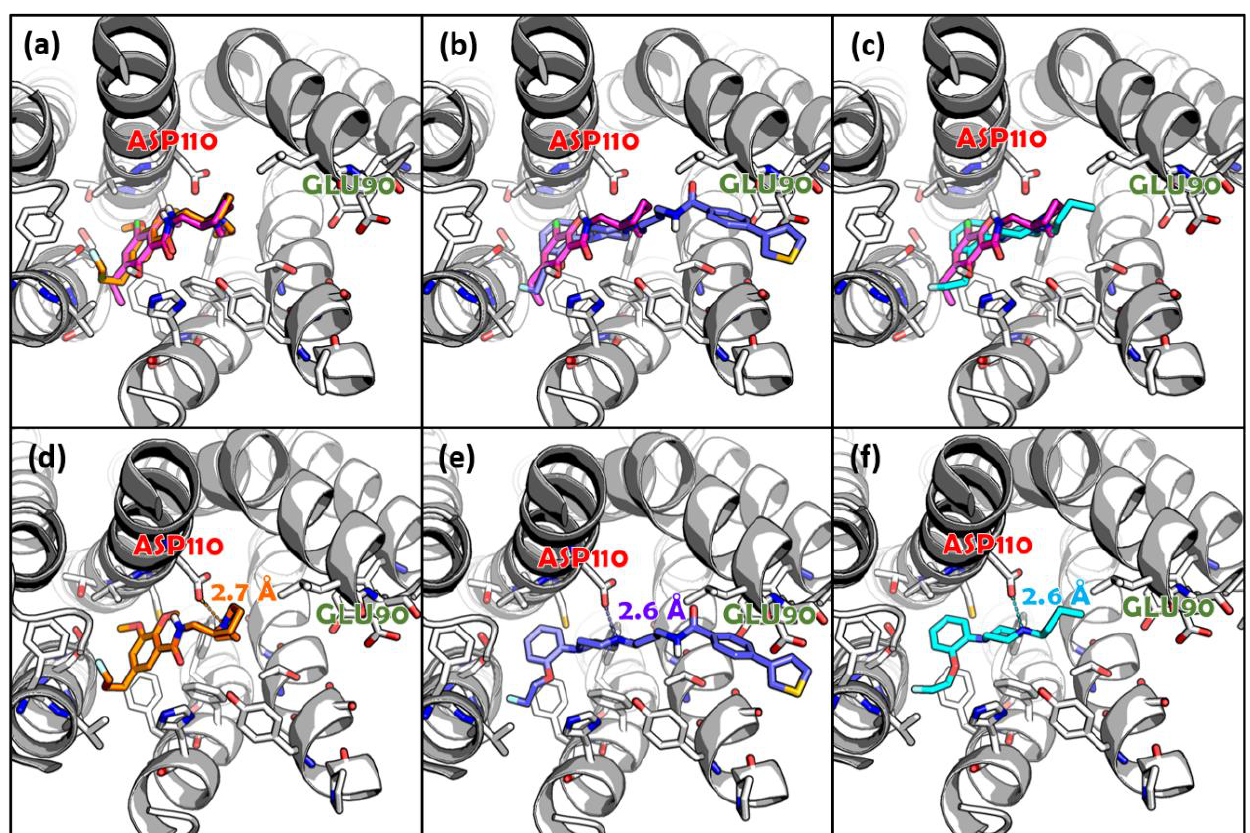
Figure 3. Docking studies of ( a , d ) Fallypride, ( b , e ) FTP, and ( c , f ) KX-02-065 to D 3 R. Alignment of docking pose for ( a ) Fallypride, ( b ) FTP, and ( c ) KX-02-065 to the crystallographic ligand (eticlopride) in D 3 R. The individual binding poses and the distance between the protonated hydrogen of ( d ) Fallypride, ( e ) FTP, and ( f ) KX-02-065. Color label: purple (eticlopride); orange (Fallypride); blue (FTP); cyan (KX-02-065).